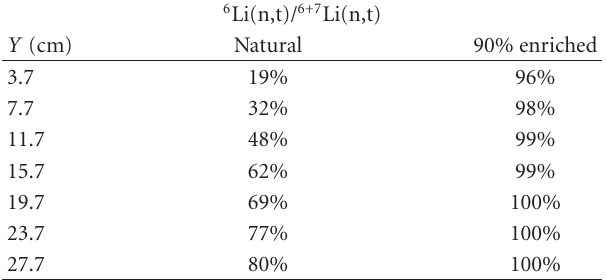
Table 3: Contribution of 6 Li(n,t) and 7 Li(n,nt).